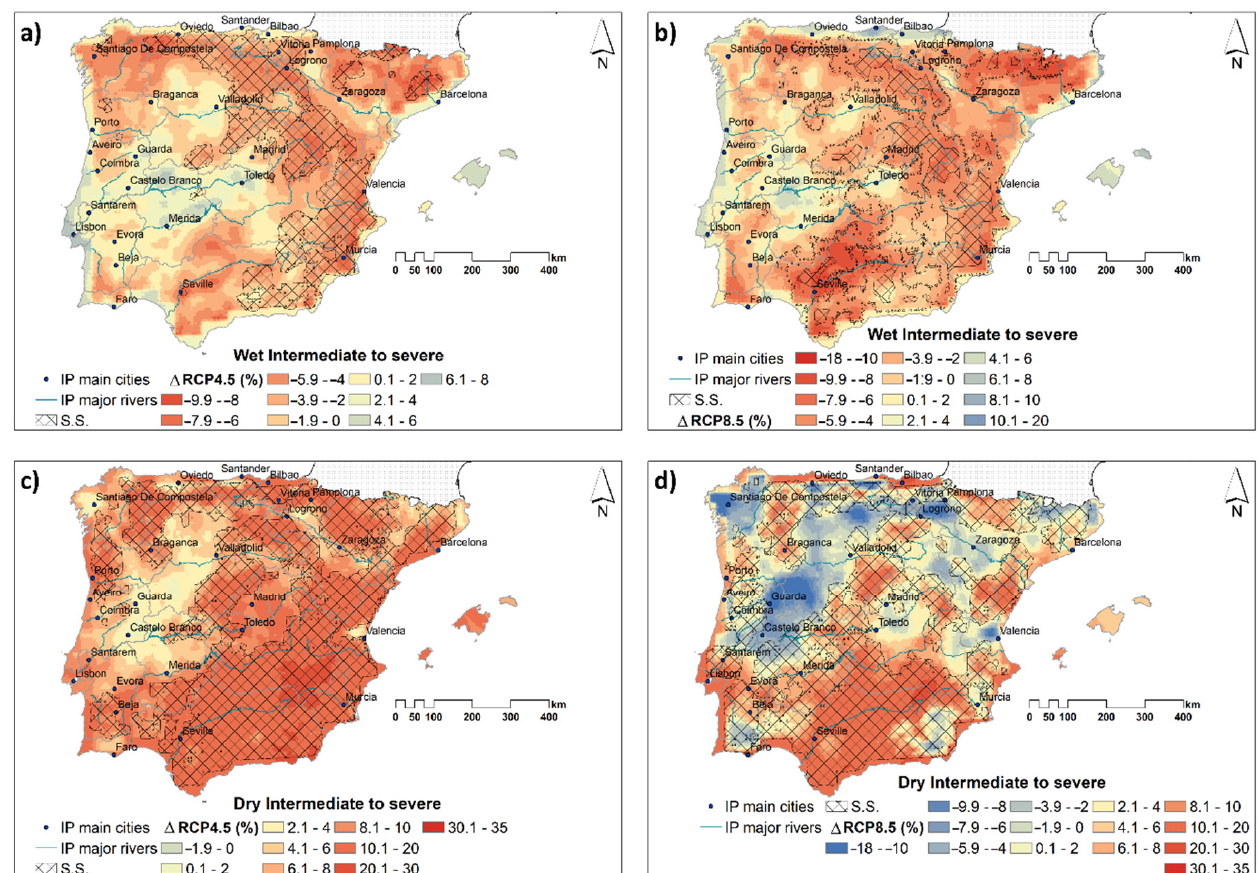
Figure 11. Statistically significant differences (MWW at a 5% significance level) between 2041–2070 and 1961–1990 for the frequency, in %, for the 12m-WASP intermediate-to-severe wet events in IP under ( a ) RCP4.5 and ( b ) RCP8.5; and for the intermediate-to-severe dry events under ( c ) RCP4.5 and ( d ) RCP8.5 (Note: NUTS 2 in grey contours; and ∆(2041–2070– ∆ 1961–1990)).